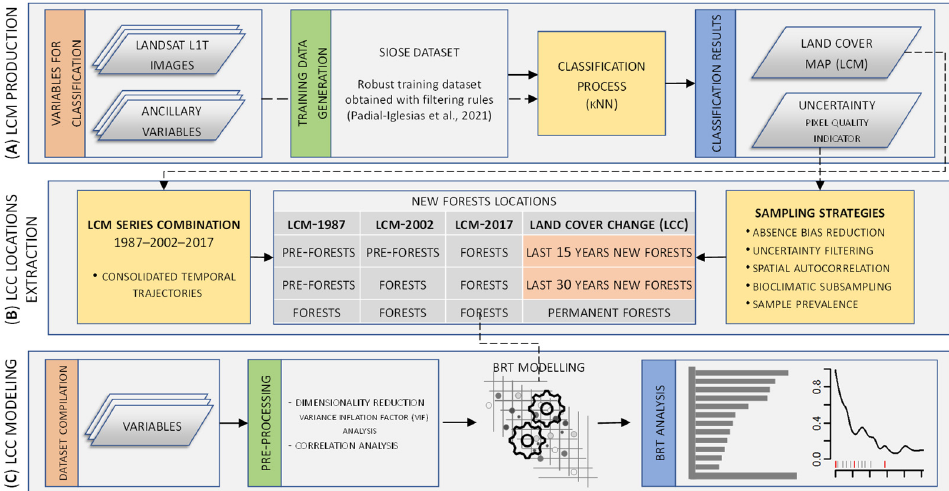
Figure 2. Methodological workflow. LCM processing ( A ) provided three temporal thematic maps and their associated uncertainty layers. In ( B ), locations of forest expansion from crops, shrublands, and grasslands ( PRE - FORESTS ) were extracted considering sampling strategies. Boosted regression trees (BRTs) were used to analyze the drivers involved ( C ) in NF occurrence.